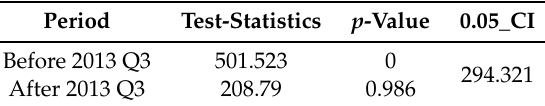
Table 3. χ 2 test (bulk).